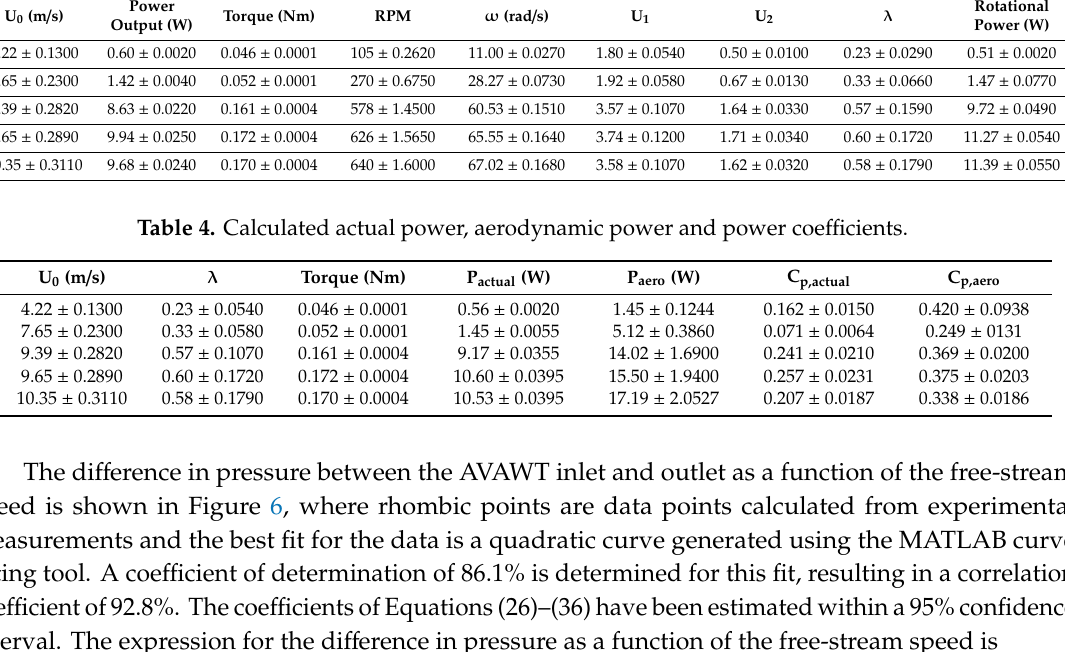
Table 3. Calculated angular speed, rotational power and tip-speed ratio. Table 4. Calculated actual power, aerodynamic power and power coefficients.